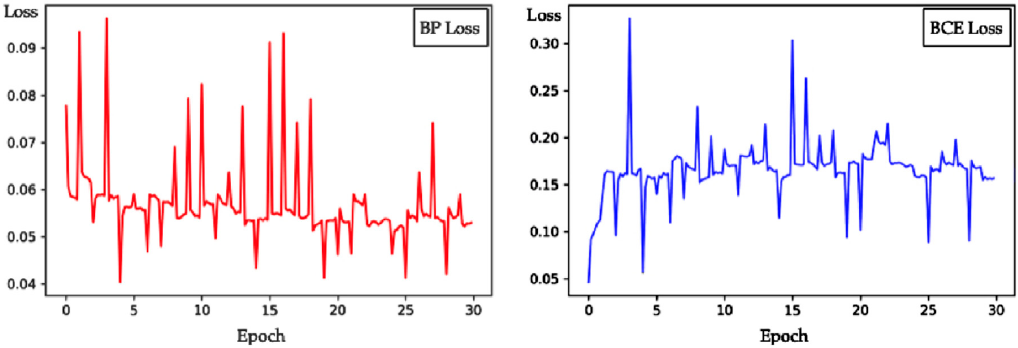
Figure 7. Diagram of the proposed BP loss and BCE loss during refining the naive UNet-Res34. The sharp peaks periodically appear in these two curves, which are caused by the numerical instability at the start of every epoch. It can be seen from Figure 7 that the BP loss gradually decreases during the refining stage, while the BCE loss dramatically increases during the first several epochs. After that, the curve of BP loss fluctuates between 0.05 and 0.06, and BCE loss becomes stable near 0.15. This phenomenon indicates that the structural information embeddings break the balance of information and semantic information is reconstructed in a short time.